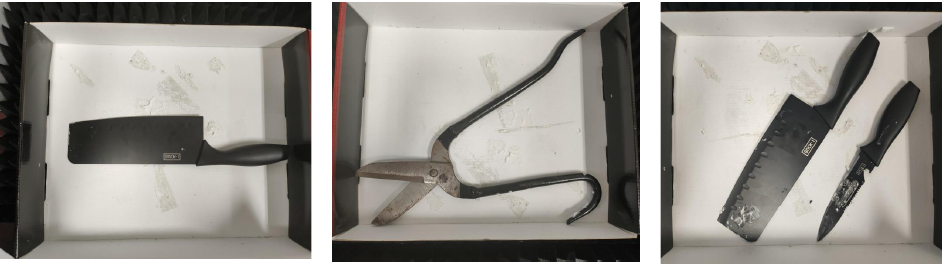
Figure 10. The optical images. Left is a concealed knife; Middle is a concealed snips; Right is concealed knife and stiletto.